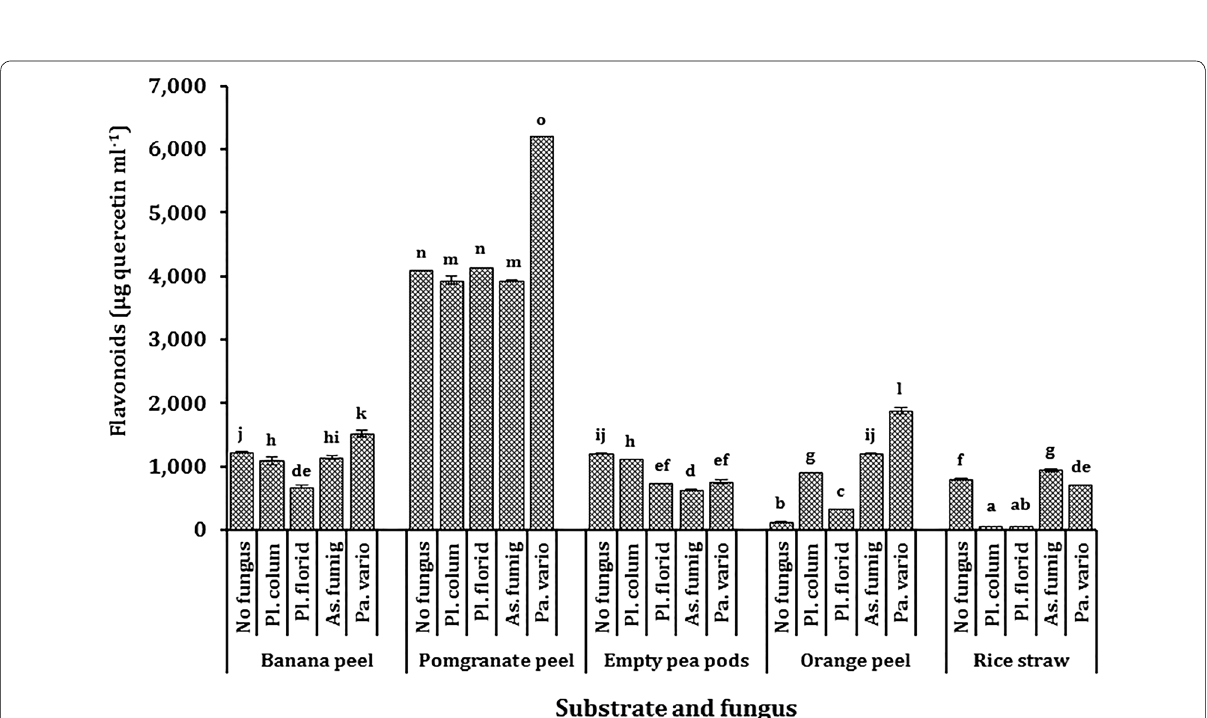
Fig. 2 Flavonoid content of an SSFS employing two basidiomycete fungi: P. columbinus and P. floridanus and two ascomycetes: A. fumigatus and P. variotii on peels of banana, pomegranate and orange, empty pods of pea and rice straw. Each column represents the mean of three replicates Columns with common letters are not significantly different at P <